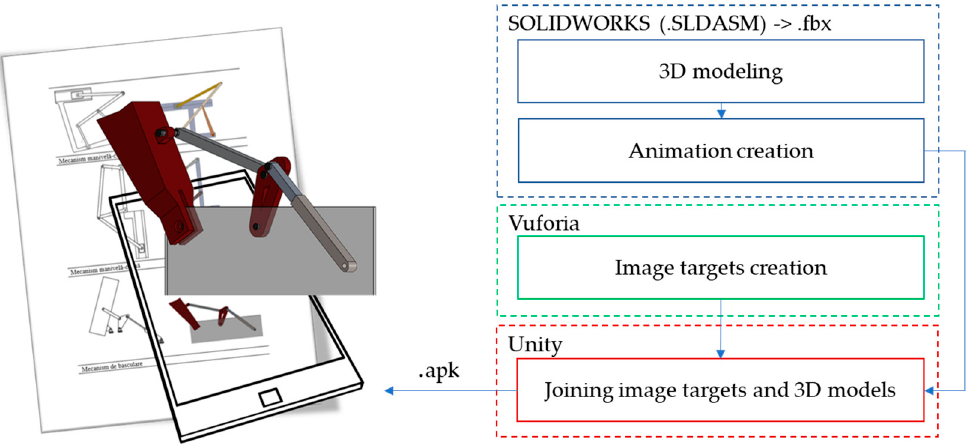
Figure 5. Block diagram of “AR Mecs” software implementation.